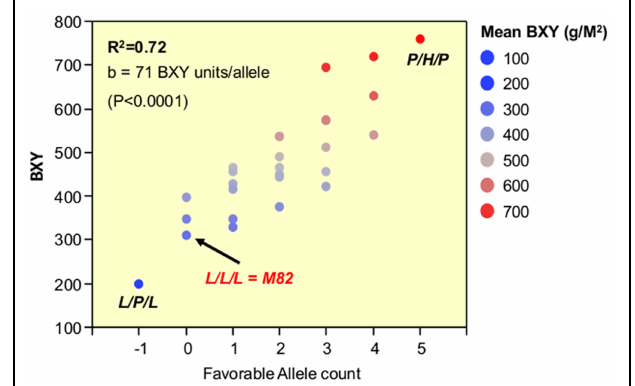
FIGURE 7 | Linear pyramiding effect: regression of favorable allele count against BXY, across 27 segregants from the IL789 pyramid. The X axis is the favorable ( S. pennellii ) allele count. All wild alleles were counted in the same manner as + 1, except for the pennellii allele at IL8-3 when present as a homozygote (P); this genotype was counted as − 1 due to the negative impact of a recessive gene within this introgression causing partial